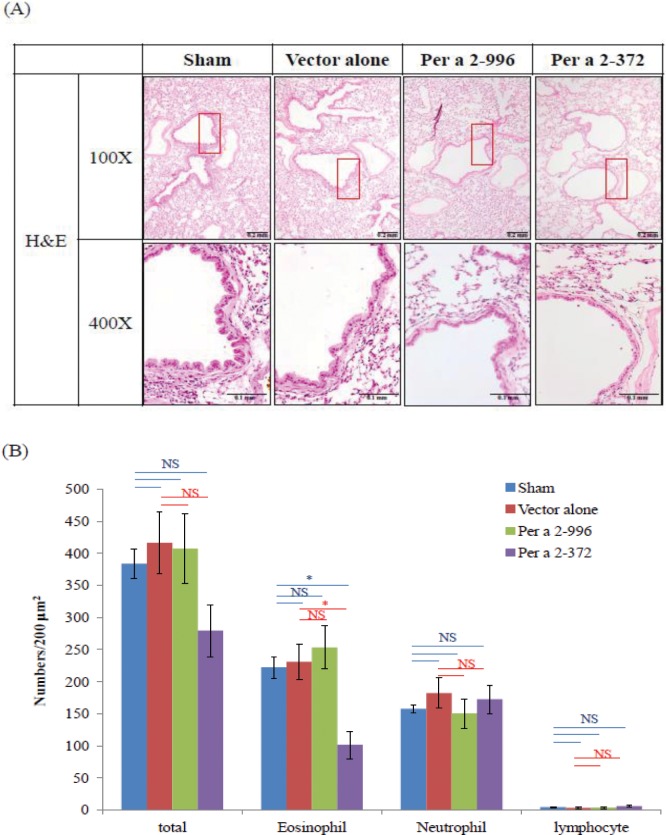
Effect of plant vaccine on histopathology of lung inflammation.(A) The representative lung sections obtained 48 h after intranasal challenge and stained with H&E. (B) The infiltrating inflammation cells were quantified under 400-fold view. The results are expressed as mean ± SEM (n = 5–6 per group) of the cell number per square millimeter of lung tissues. The statistical significance of differences among groups was assessed by the Dunnett’s test. * denoted p<0.05.